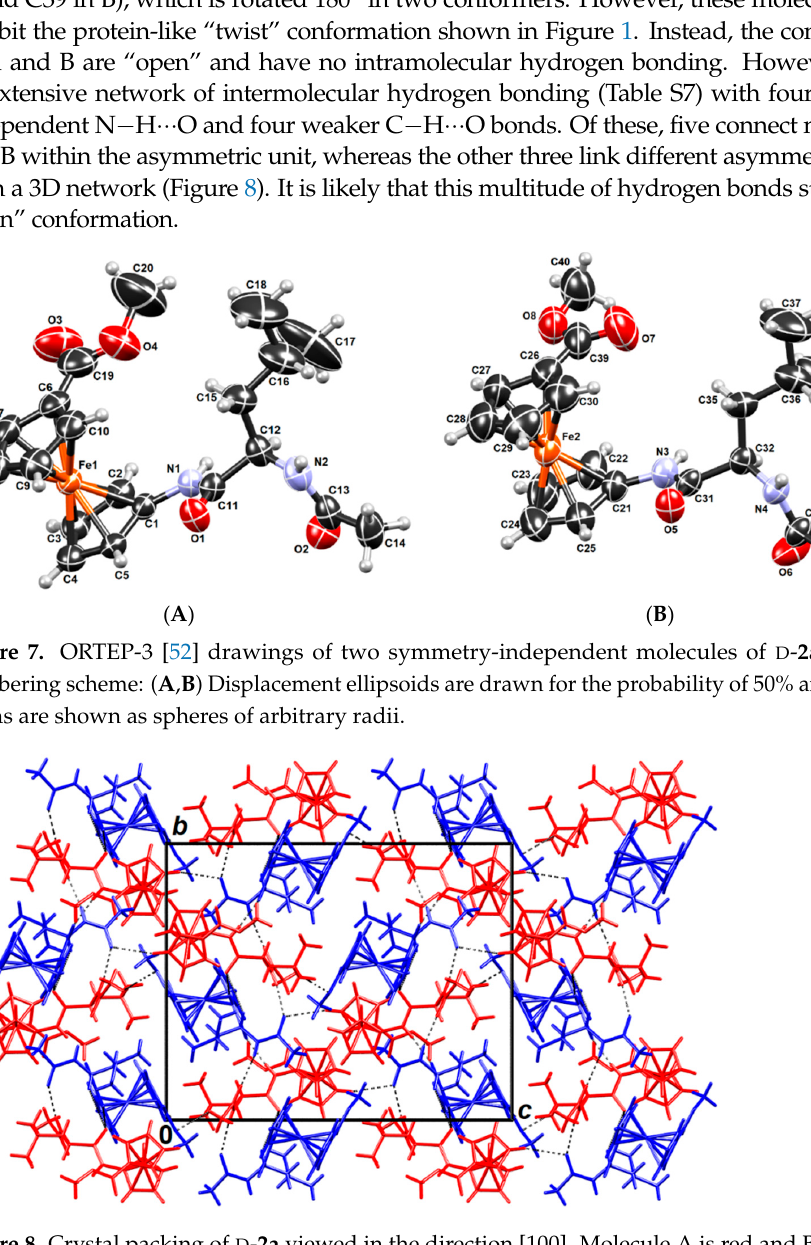
Figure 8. Crystal packing of D - 2a viewed in the direction [100]. Molecule A is red and B is blue, and hydrogen bonds are shown as black dashed lines.